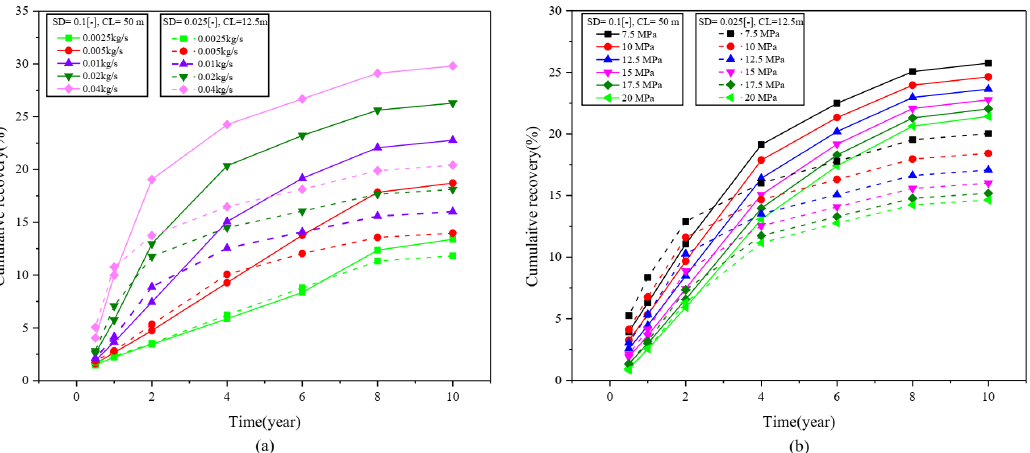
Figure 16. The ( a ) cumulative recovery curves under different injection rate, ( b ) cumulative recovery curves under different production pressure.